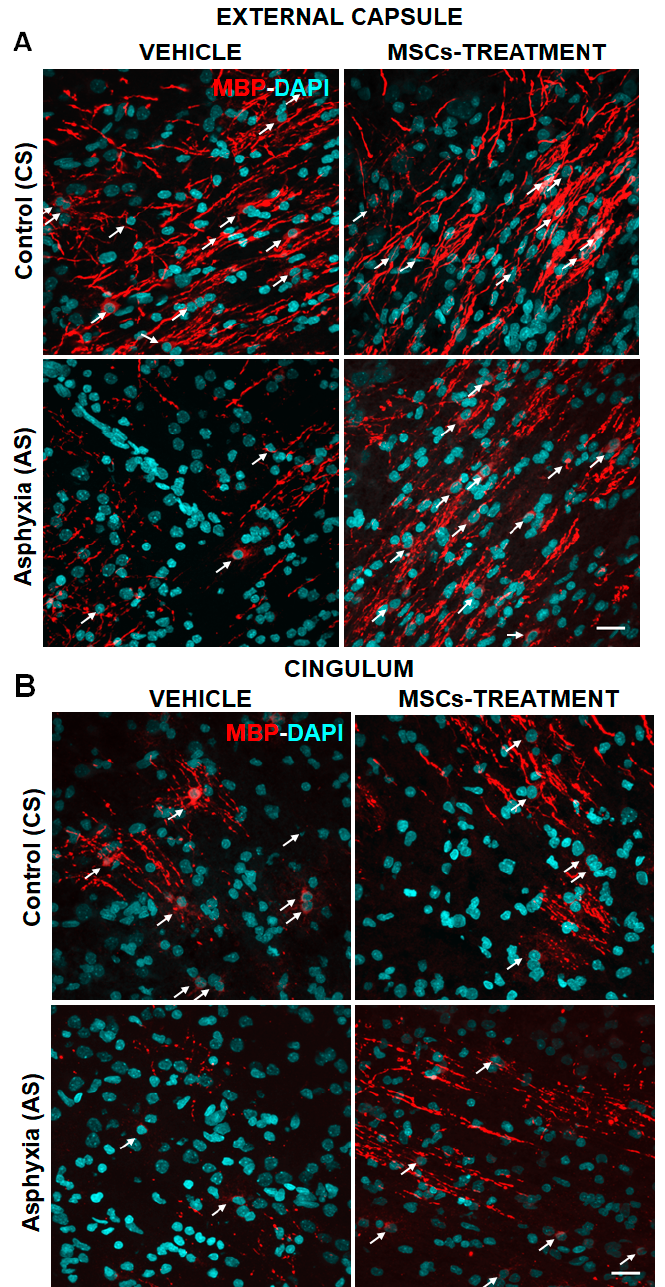
Figure 4. Effect of MSCs treatment on myelination and mature oligodendrocyte (OLs) injury induced by perinatal asphyxia (PA), measured at P7 in external capsule ( A ), and cingulum ( B ) of control (CS) and (AS) rats. Representative microphotographs obtained by confocal microscopy showing myelin basic protein (MBP; red) and DAPI (blue; nuclei)-positive cells in external capsule (4A); and cingulum (4B) from control (CS) and asphyxia-exposed (AS) rat neonates, including vehicle and MSCs treated groups. Microphotographs show MBP, indicating myelinated fibers (white head arrows) and mature oligodendrocytes (OL) (white arrows). Scale bar: 20 µ m. The density of MBP and number of MBP-DAPI cells/mm 3 is increased in MSCs- versus vehicle-treated AS neonates in all evaluated regions.